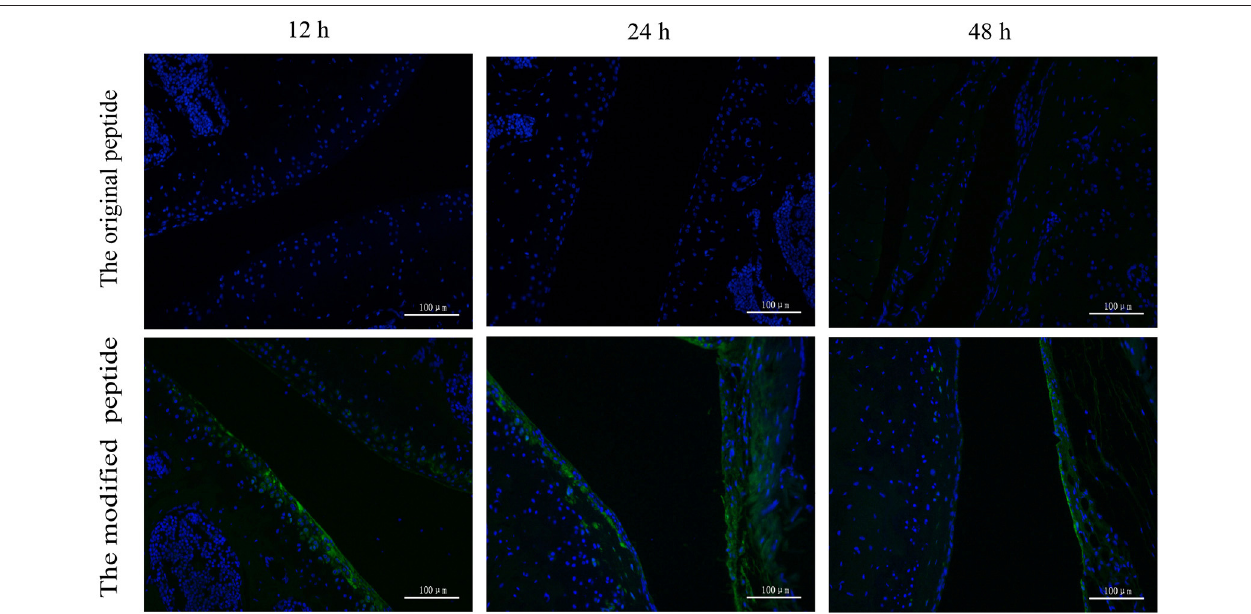
FIGURE 4 | Retention time of the modified peptide in the joint cavities was prolonged. The biotin-labeled original or modified peptide was injected into the knee joint and then the knee joints were dissected at 12, 24, and 48h and probed with streptavidin-FITC in immunofluorescence assays.